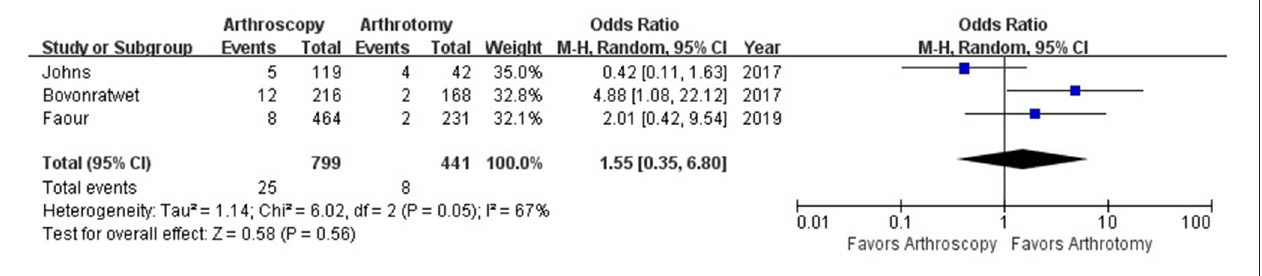
FIGURE 8 | Forest plots of the comparison of arthroscopy and arthrotomy for